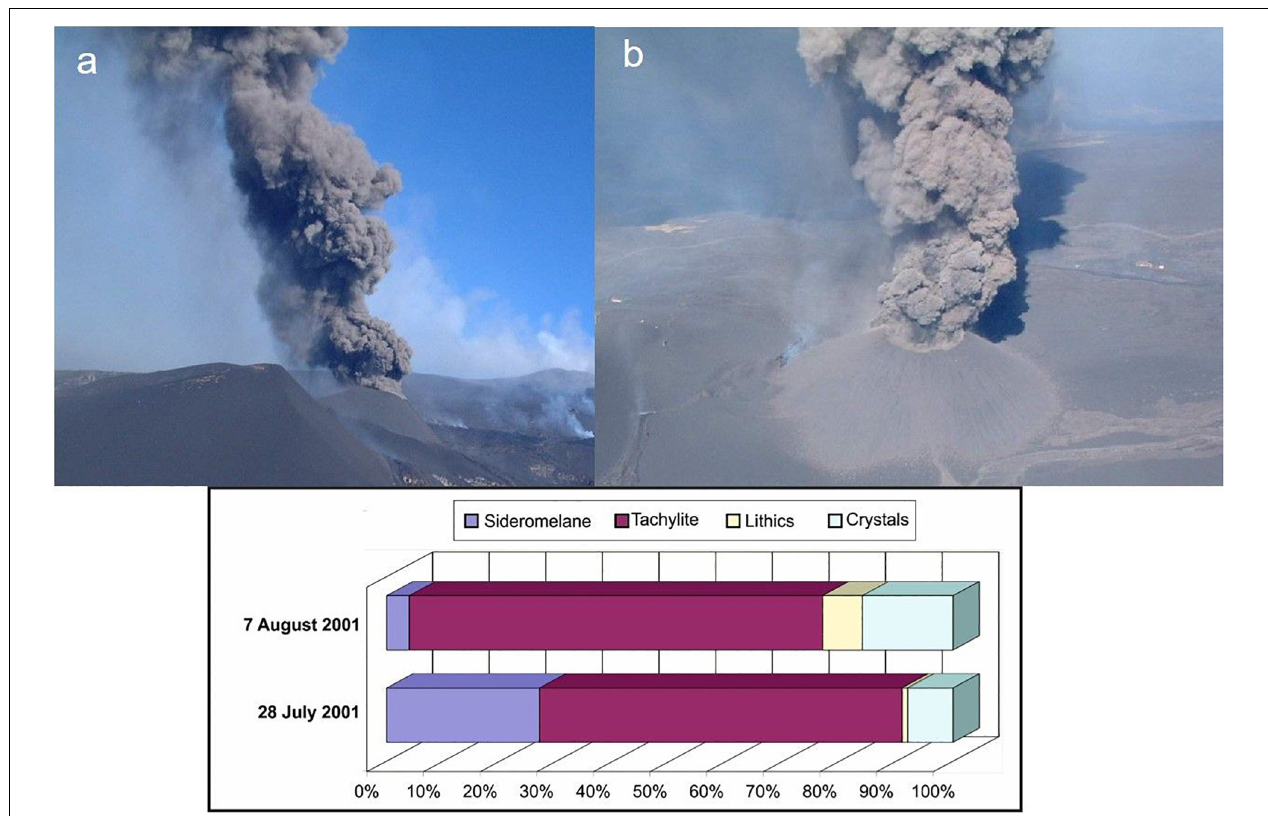
FIGURE 6 | Images (a,b) of the pulsing ash plume generated during the final phase of activity of the vent at 2550 m a.s.l. in 2001, and diagrams of ash componentry at the beginning and at the end of this final phase of activity. Reproduced with